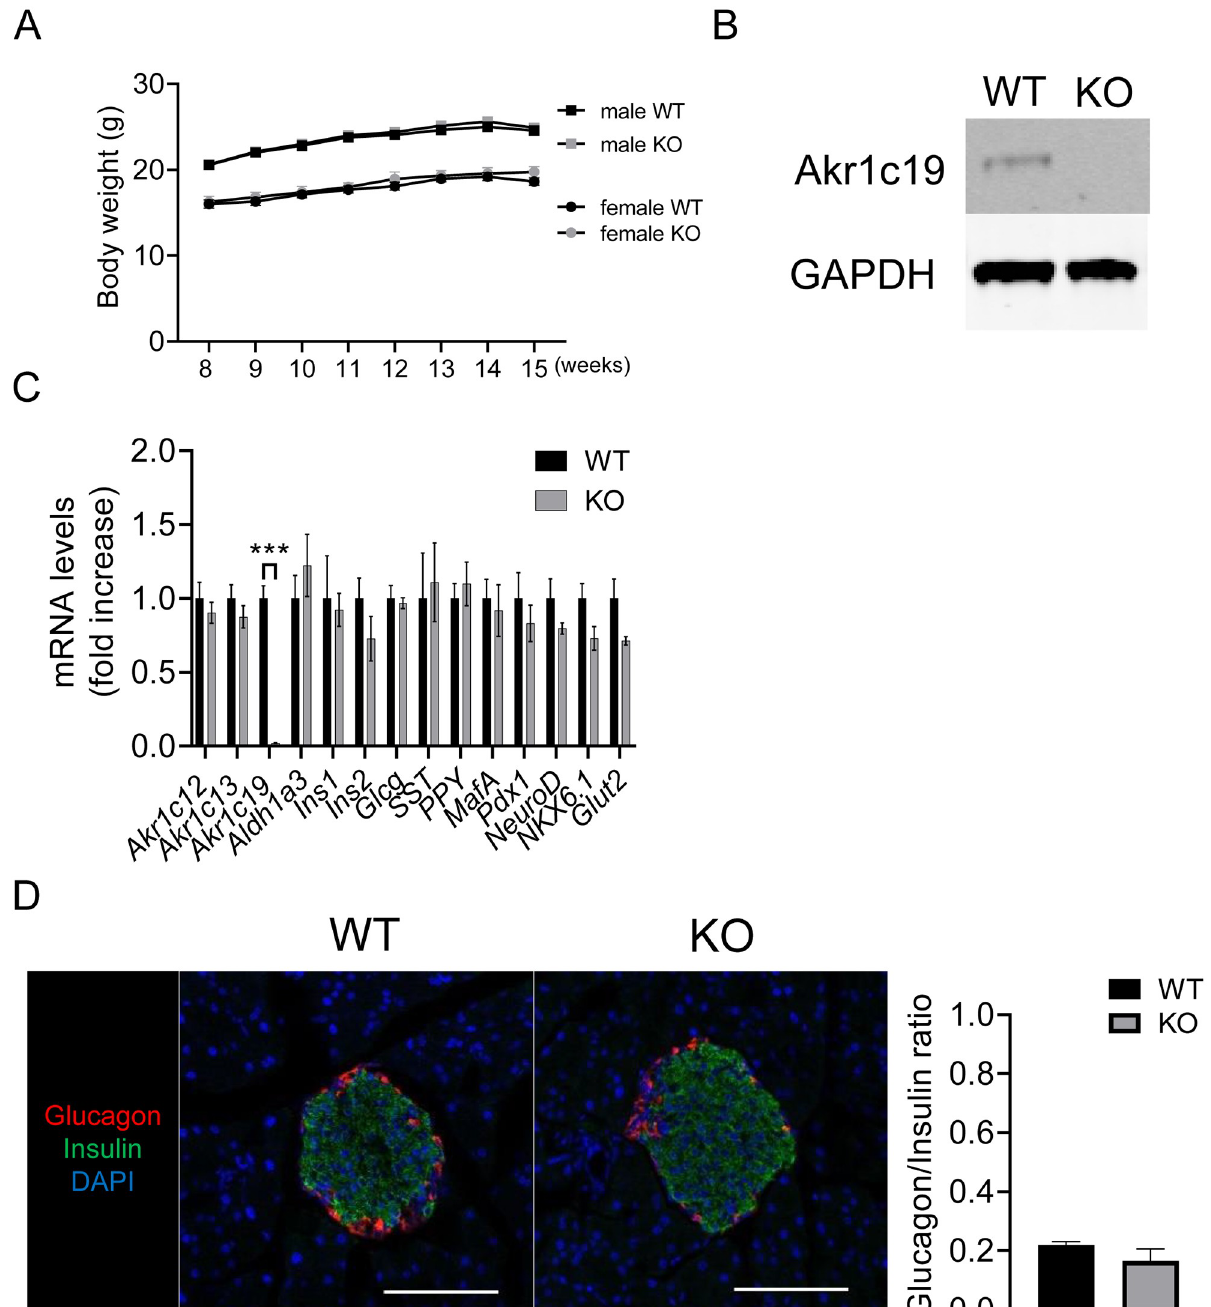
Fig 3. Development and islet morphology of Akr1c19 knockout mice. (A) Changes in body weight in of male and female Akr1c19 knockout (KO) mice. (B) Immunoblotting for Akr1c19 and (C) gene expression analysis in isolated islets from WT and KO mice. (D) Immunostaining for glucagon (red), insulin (green), and DAPI (blue) in WT and KO islets and quantification of glucagon/insulin ratio. Scale bar = 100 μ m. All values represent mean ± SEM. ��� p < 0.001 by Student’s t-test.